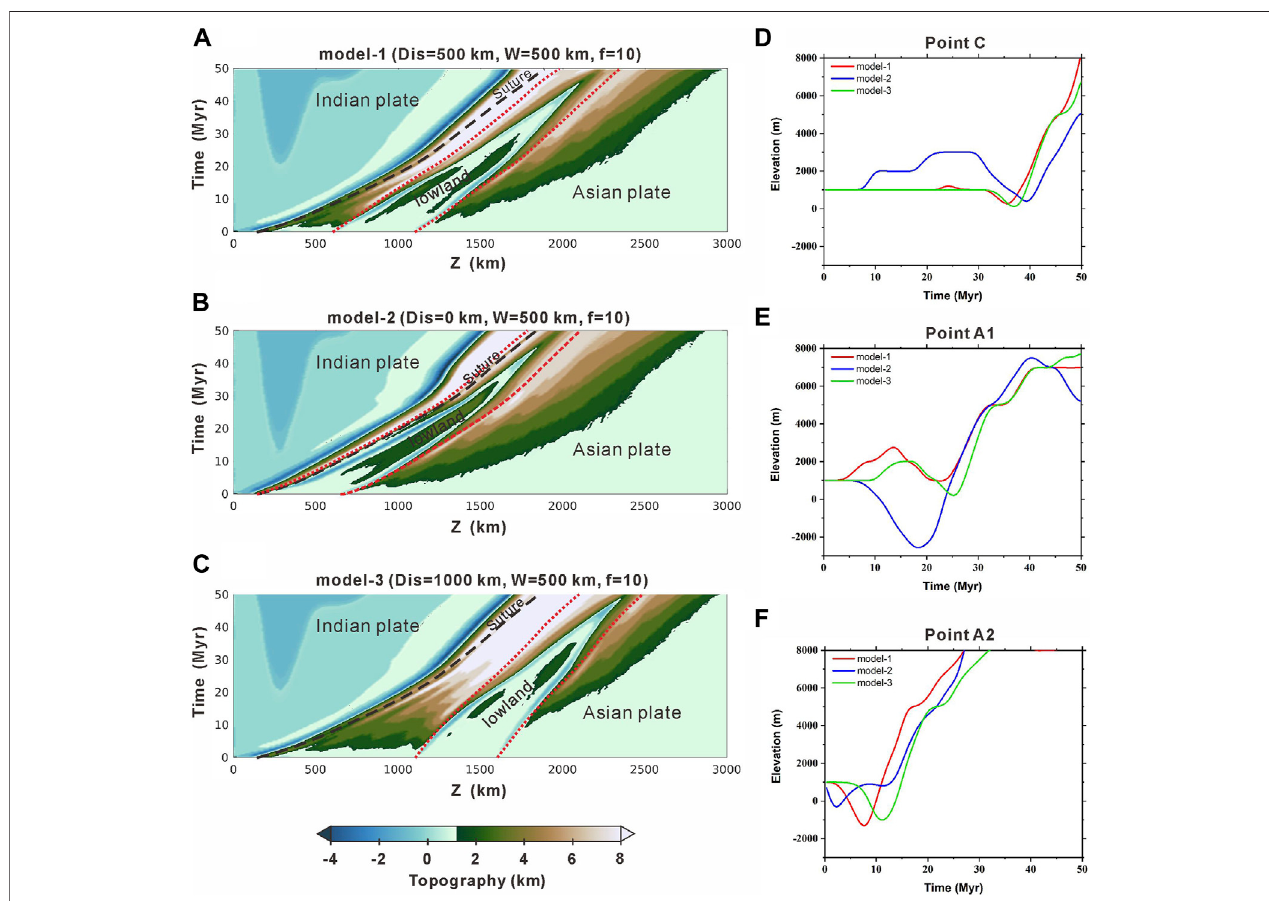
FIGURE7| Contrastingthetopographicfeaturesamongmode-1,model-2,andmodel-3.Topographicevolutionwithtimealongsectionx=2000 kmin (A) model- 1 (B) model-2, and (C) model-3. The red dotted curves limiting the region of the strong basins and the black dashed curves represent the sutures. Uplift histories of (D) pointC (E) pointA1,and (F) pointA2indifferentmodels.Redcurvesshowtheelevationhistoryofmodel-1,bluecurvesshowtheelevationhistoryofmodel-2,andgreen curves show the elevation history of model-3.